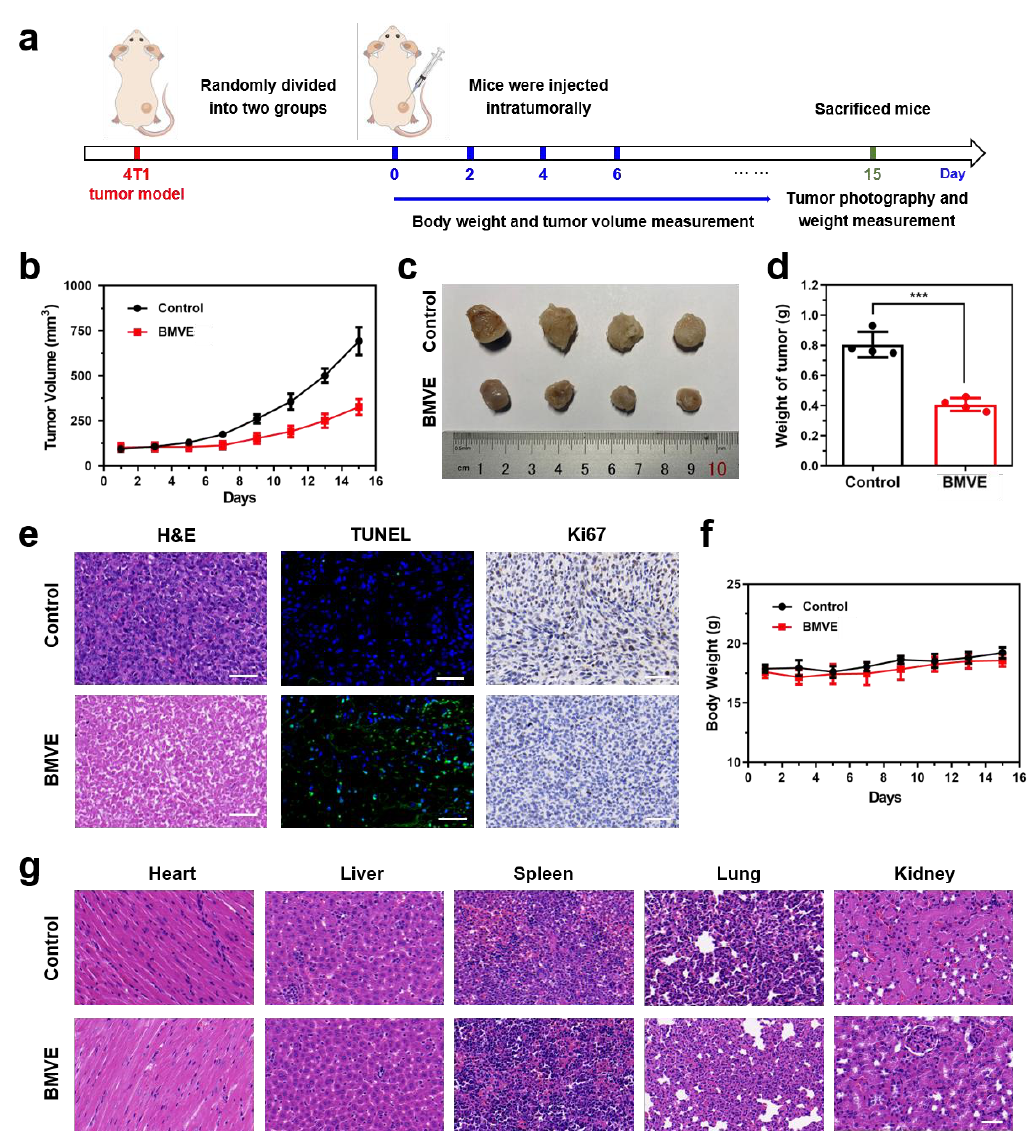
Figure 6. In vivo therapeutic effect and safety evaluation of BMVE on tumors. ( a ) Schematic diagram of animal treatment process. ( b ) Statistics of tumor volume of mice in the control group and the BMVE-treated group. ( c ) Representative images of 4T1 tumors. ( d ) Statistics of tumor weight in the control group and the BMVE-treated group, mean ± SD, *** p < 0.001, n = 4. ( e ) H&E staining, TUNEL staining and Ki67 staining of tumor sections of control mice and BMVE-treated mice (scale bar = 50 μm). ( f ) Statistics of mice weight in the control group and the BMVE-treated group. ( g ) H&E staining of the major organs of control mice and BMVE- treated mice (scale bar = 50 μm).